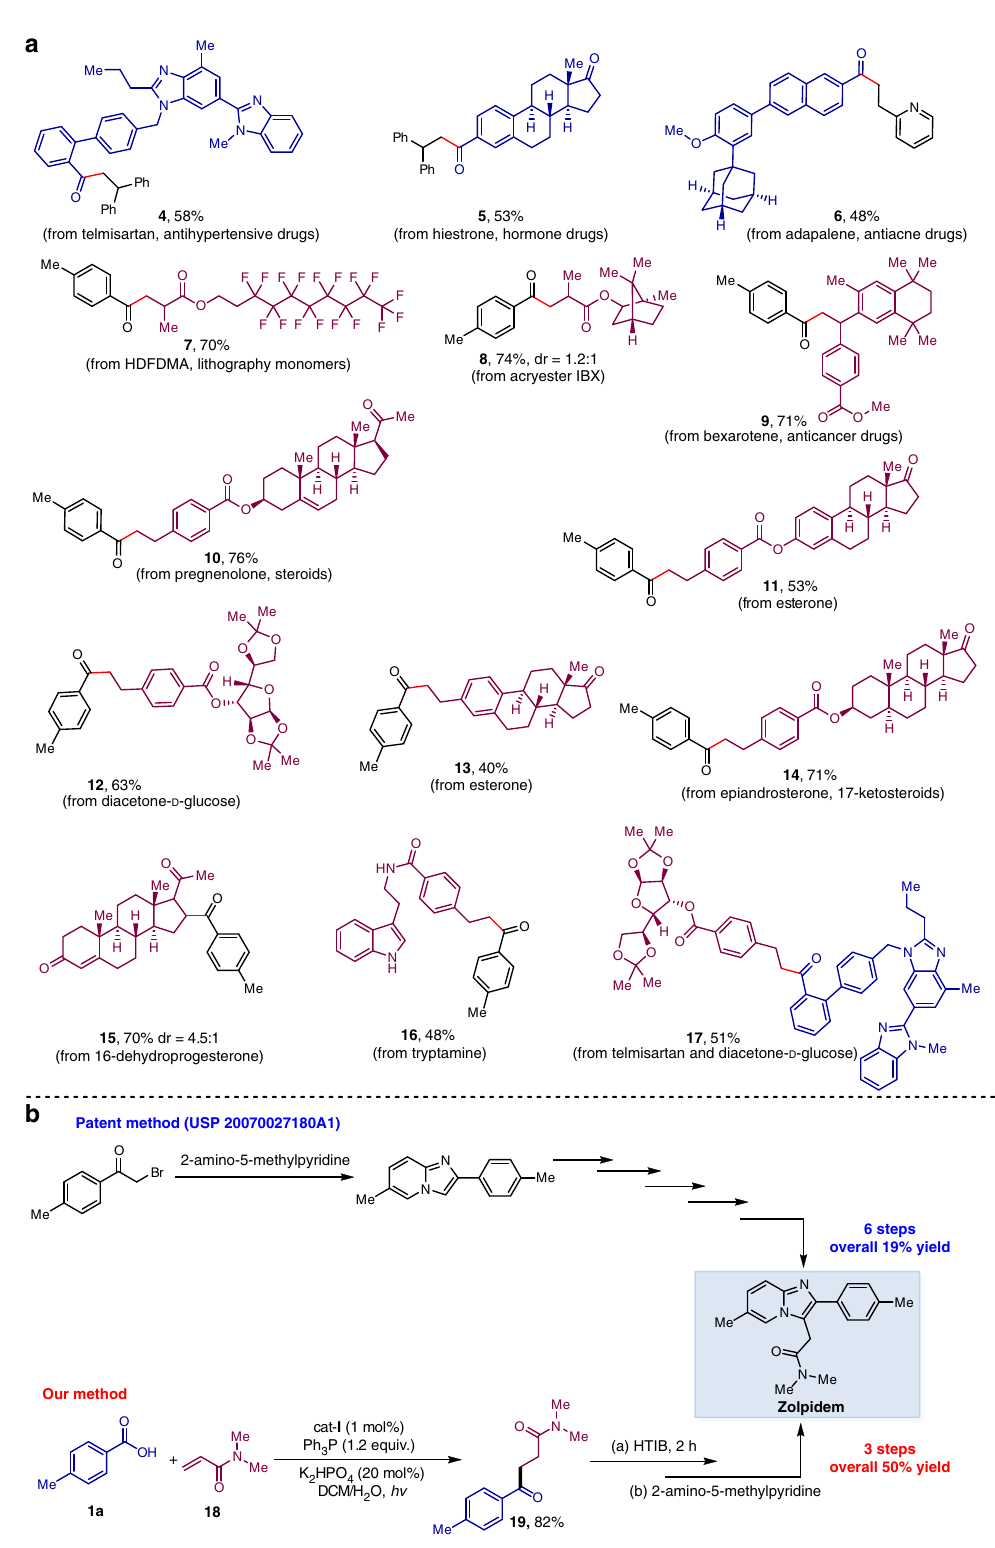
Fig. 5 Synthetic application. a Late-stage application in the complex molecules. b Synthesis of